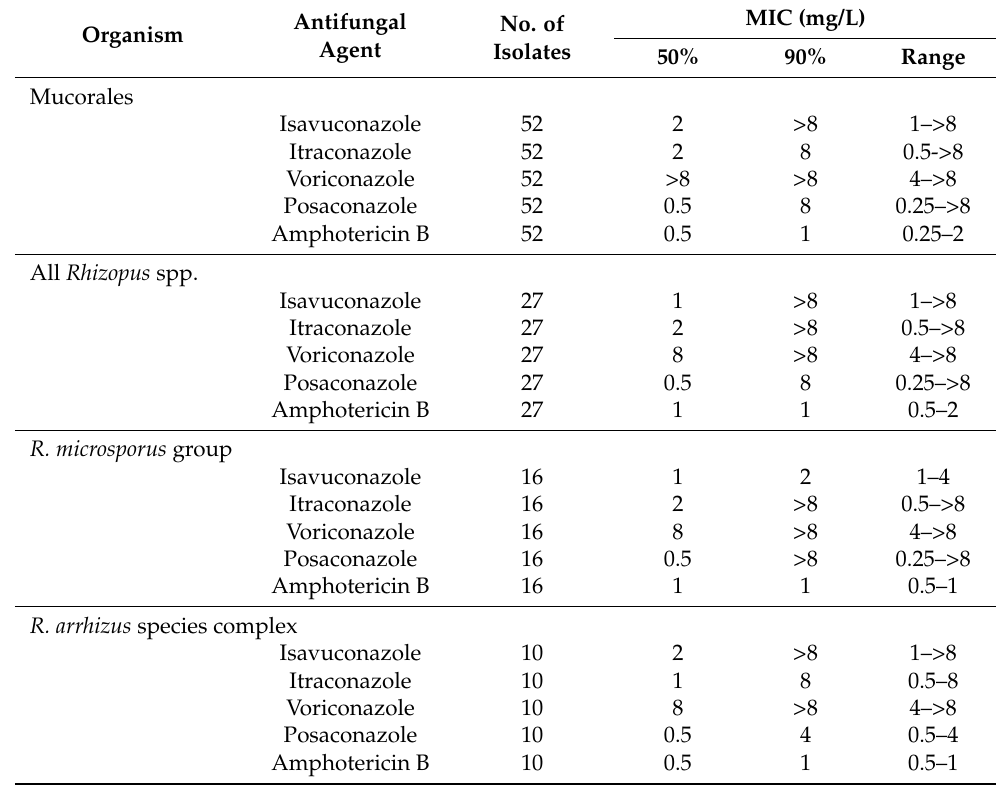
Table 2. Isavuconazole and comparators activity against Mucorales group split by genera and